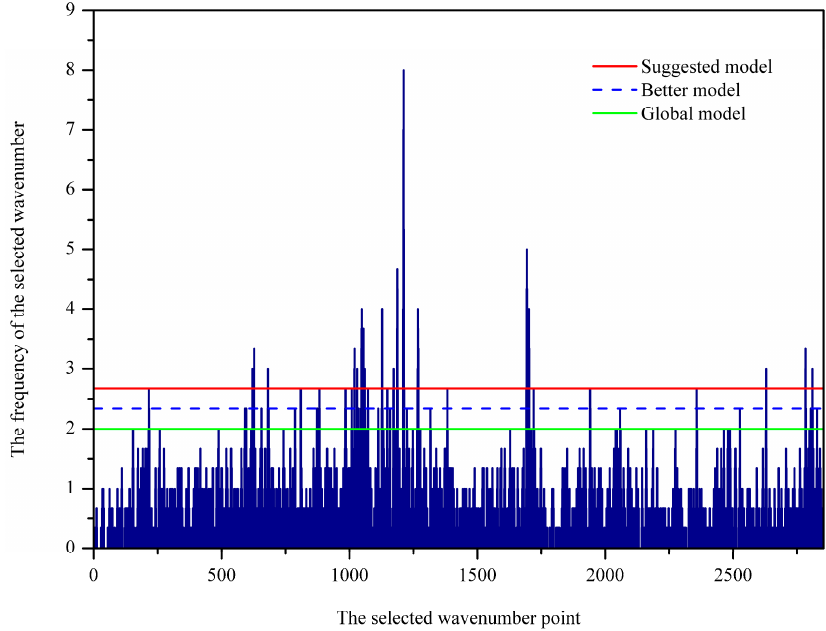
Figure 2. The histogram of frequency to be selected for individual variables.